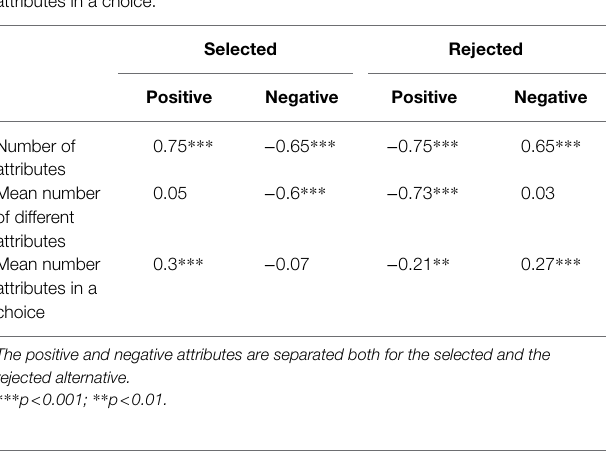
TABLE 2 | Spearman correlation coefficients between quality difference and total number of attributes, mean number of different attributes, and mean number of attributes in a choice.